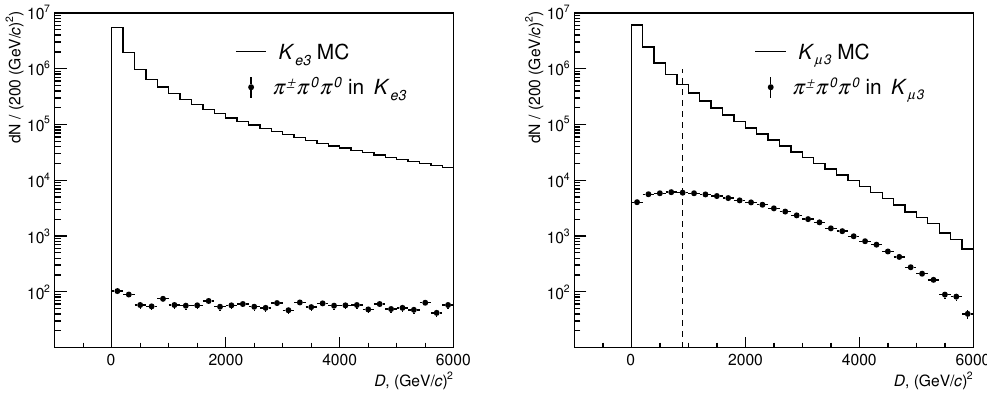
(left) and K (cid:6) e 3 (cid:22) 3